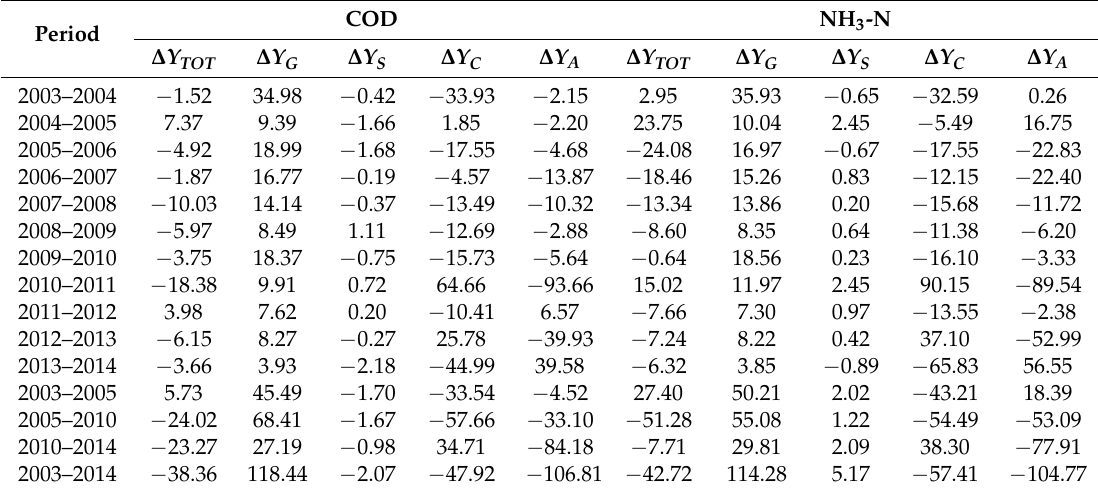
Table 1. Contributions of various factors to the changes in COD and NH 3 -N discharge (unit: %). Period